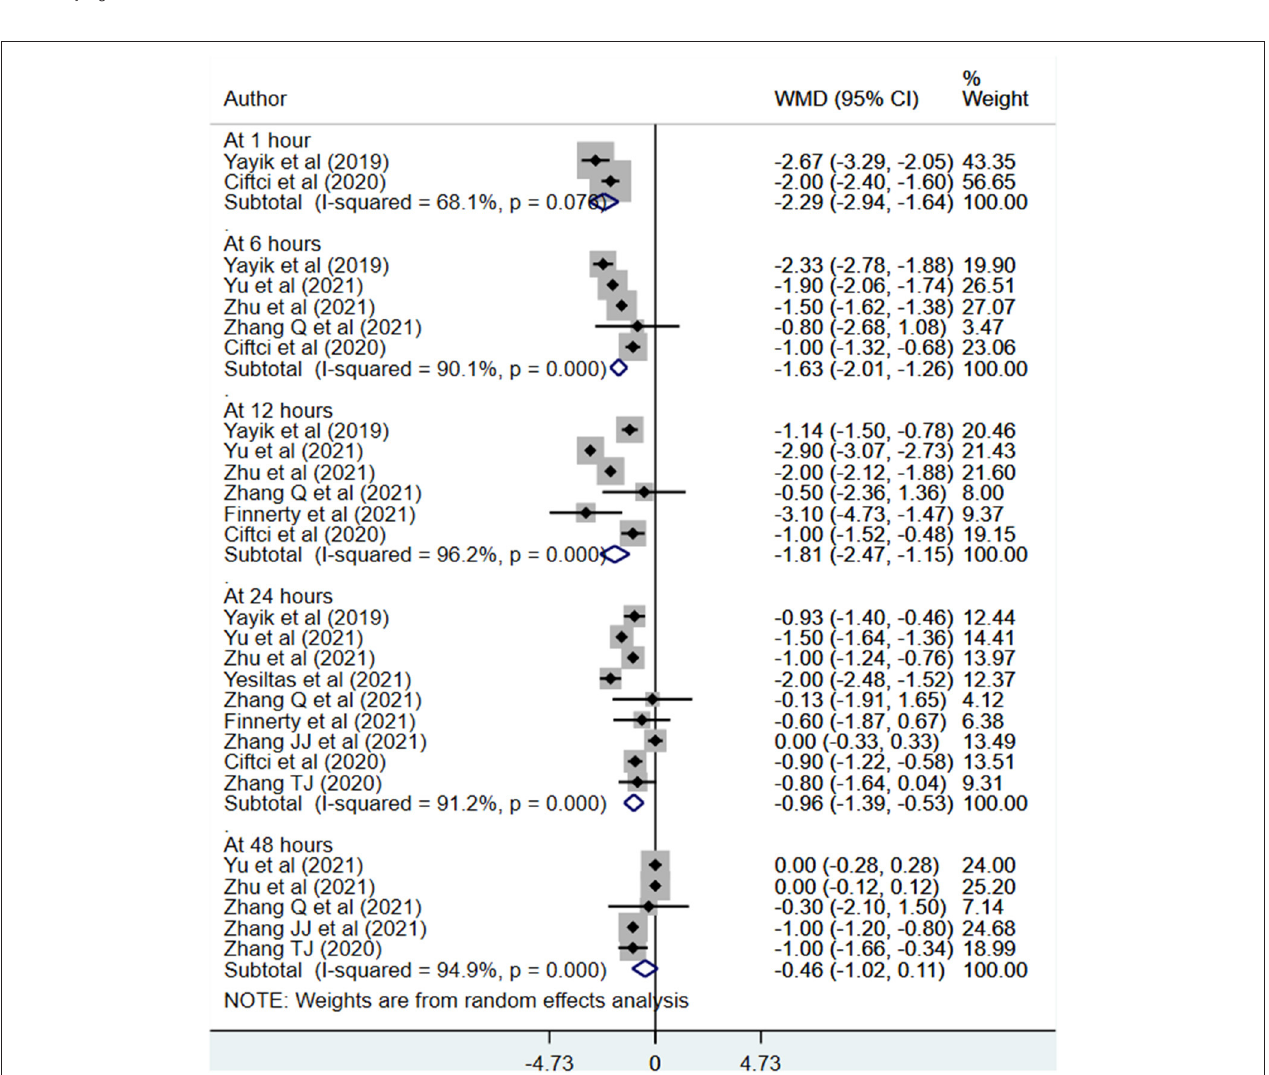
FIGURE 5 | Postoperative pain scores at movement among subjects with erector spinae plane block, compared to placebo or no